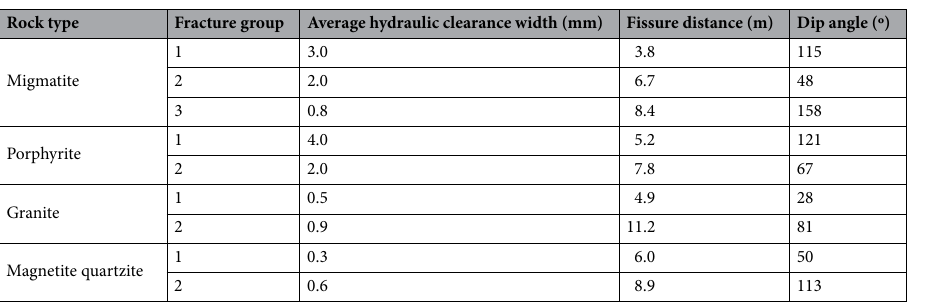
Table 3. Fracture geometric parameters.